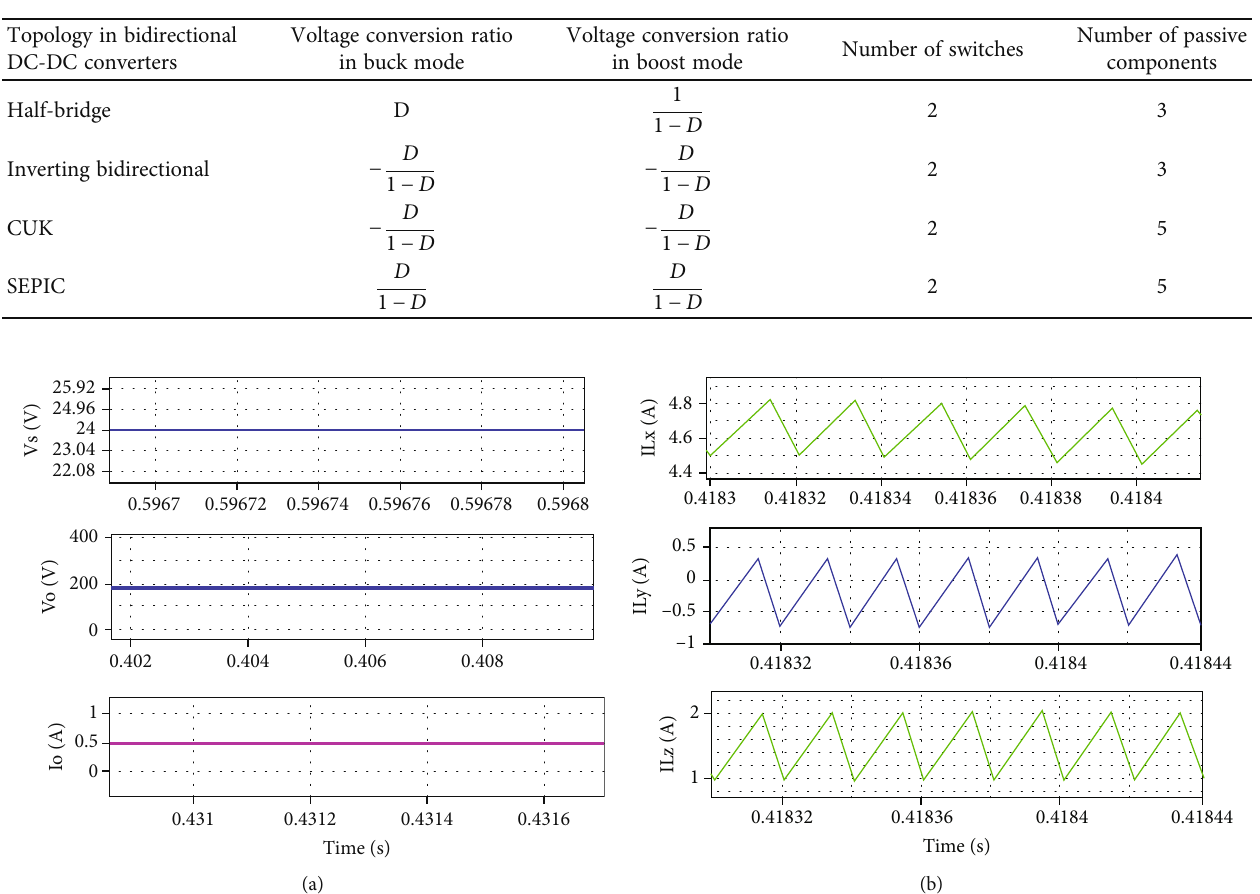
Table 3: Evaluation of the half-bridge BDC with conventional nonisolated BDCs [6].